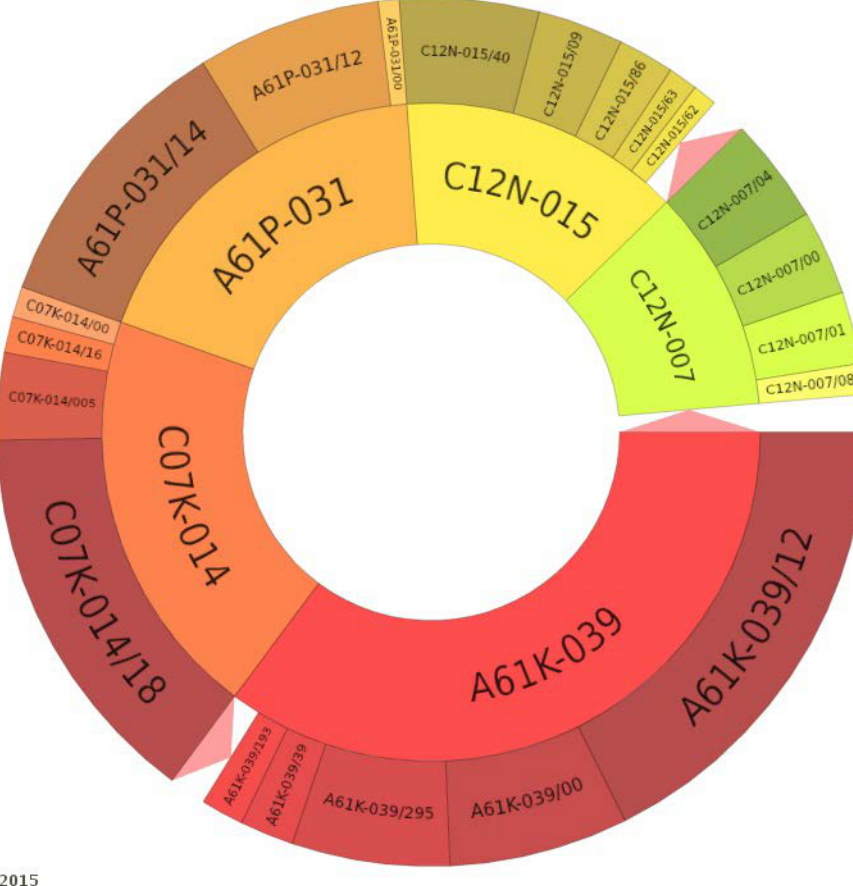
Figure 10. Technological fields of search